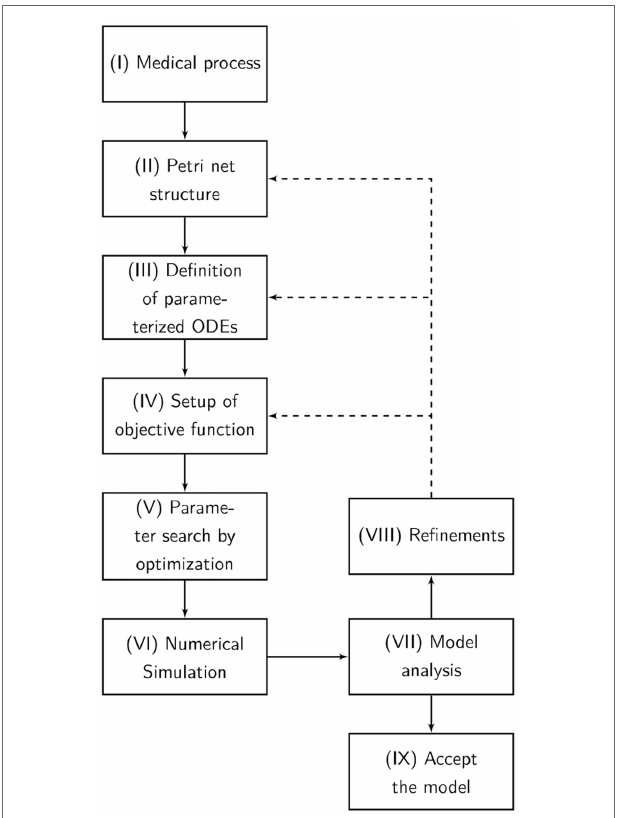
FIGURE 7 | The flowchart presents our Medical-In silico approach. It shows all the undertaken processes from the pathophysiological process to the final model. (I) The pathophysiological process is comprehensively defined. (II) Analog to the preceding description, the Petri net structure is derived. (III) Ordinary differential equations (ODEs) are extracted from the structure of the Petri net. (IV) Based on the system of ODEs, an optimization problem is formulated incorporating in vitro measurements. We might enhance the objective function with some penalty functions that drive the model into biological boundaries. (V) The ODEs are parameterized by an evolutionary strategy algorithm that minimizes the objective function. (VI) A visualization of the time course is simulated by numerical integration from the parameterized ODEs. (VII) Finally, the model is analyzed and either accepted or previous design steps are refined.